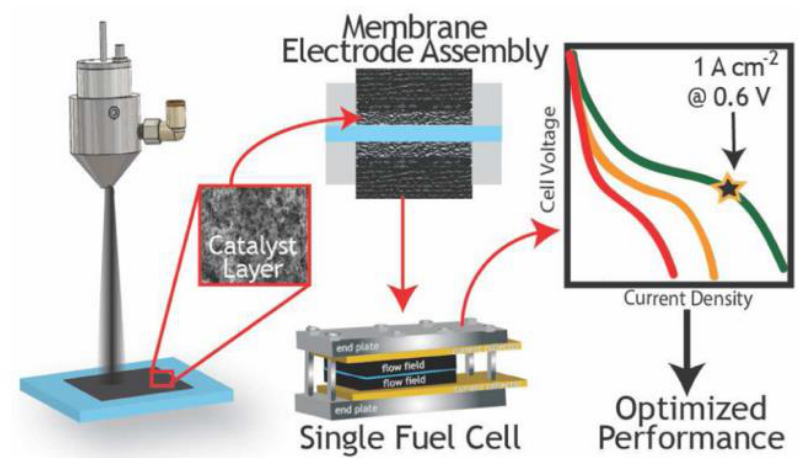
Figure 6. Schematic diagram of the CCM MEA prepared by ultrasonic spraying [51].